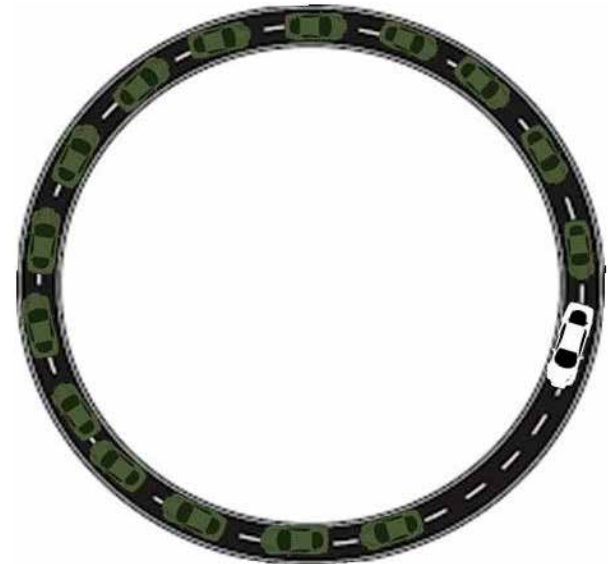
Figure 5: A platoon of one hundred vehicles running a circular road with length of 1500